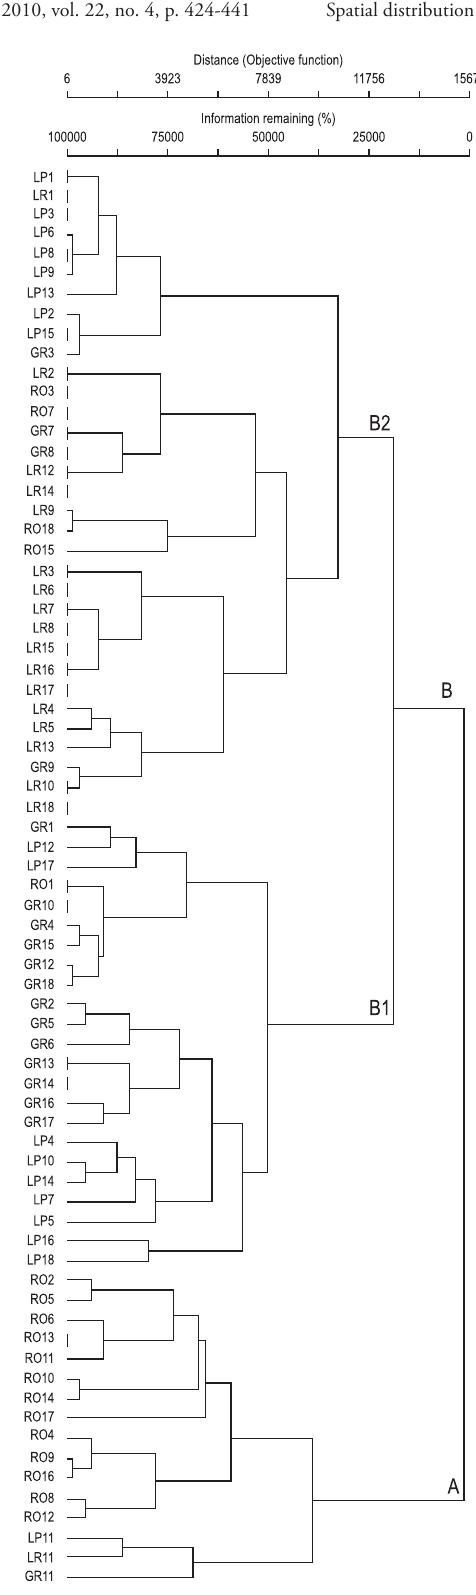
Figure 3. Cluster Analysis based on Bray-Curtis dissimilarity index using assemblages fauna abundance in the substrates collected at Serra da Bocaina streams. LP = litter from pool, LR = litter from riffles, GR = gravel, RO = rocks. Number 1 to 18 are the